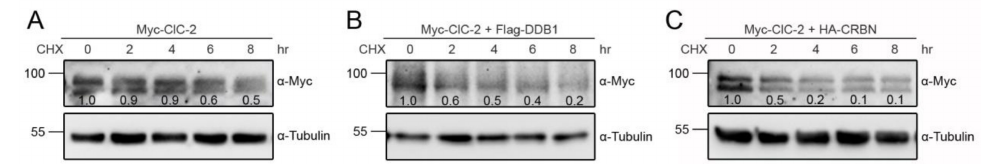
Figure 3. DDB1 and CRBN reduce ClC-2 protein stability. Representative immunoblots showing the e ff ect of vector ( A ), DDB1 ( B ), or CRBN ( C ) co-expression on ClC-2 protein turnover kinetics in HEK293T cells. Transfected cells were subject to di ff erent treatment durations (0 to 8 h) of the protein synthesis inhibitor cycloheximide (CHX). Protein densities were normalized to those of corresponding no-treatment controls at 0 h. The numbers on the immunoblot denote relative ClC-2 protein